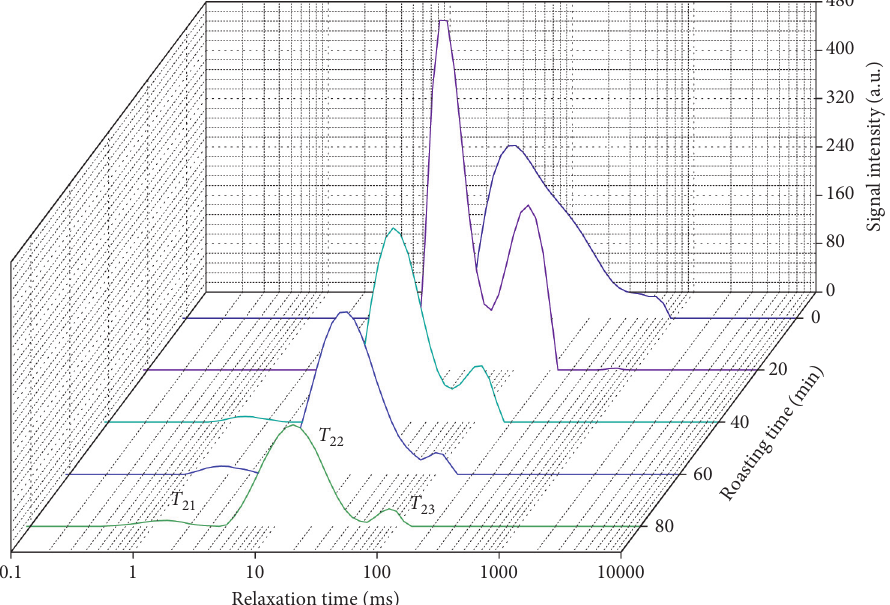
Figure 3: Characteristic LF-NMR T 2 relaxation spectra of giant salamander jerky as affected by roasting